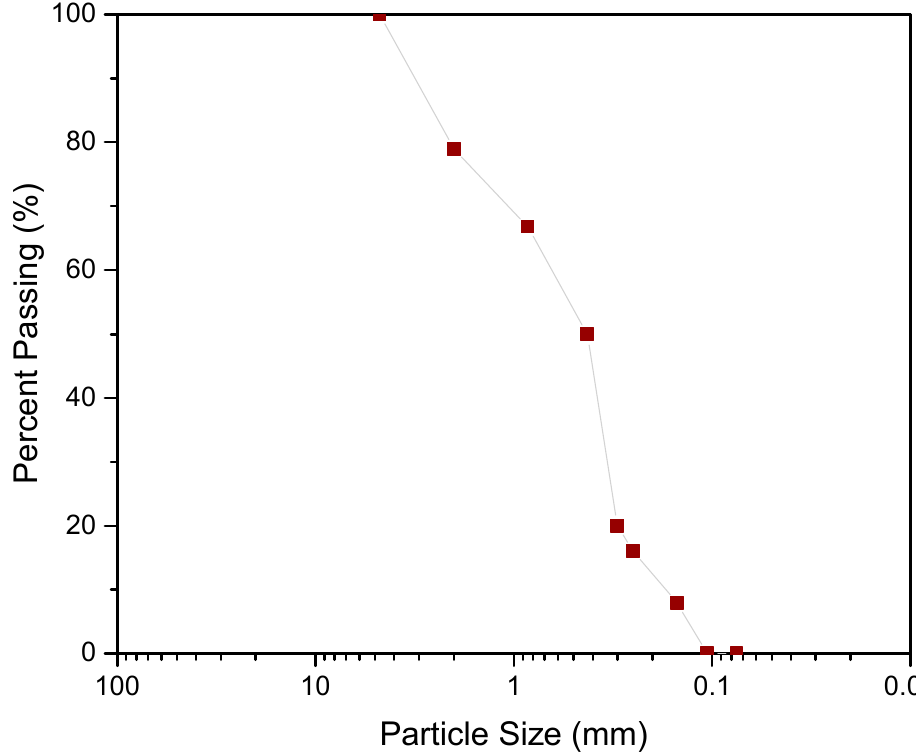
Figure 1. Particle size distribution curve of the crushed coal gangue.